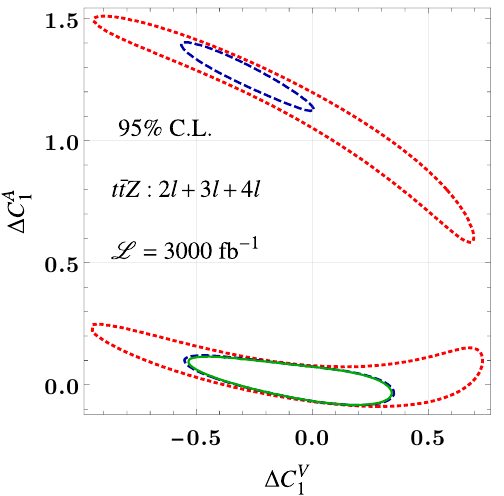
- ∆ C A combining all the leptonic channel, 1 1 √ s = 13 TeV and integrated luminosity L = 3000 fb − 1 . The